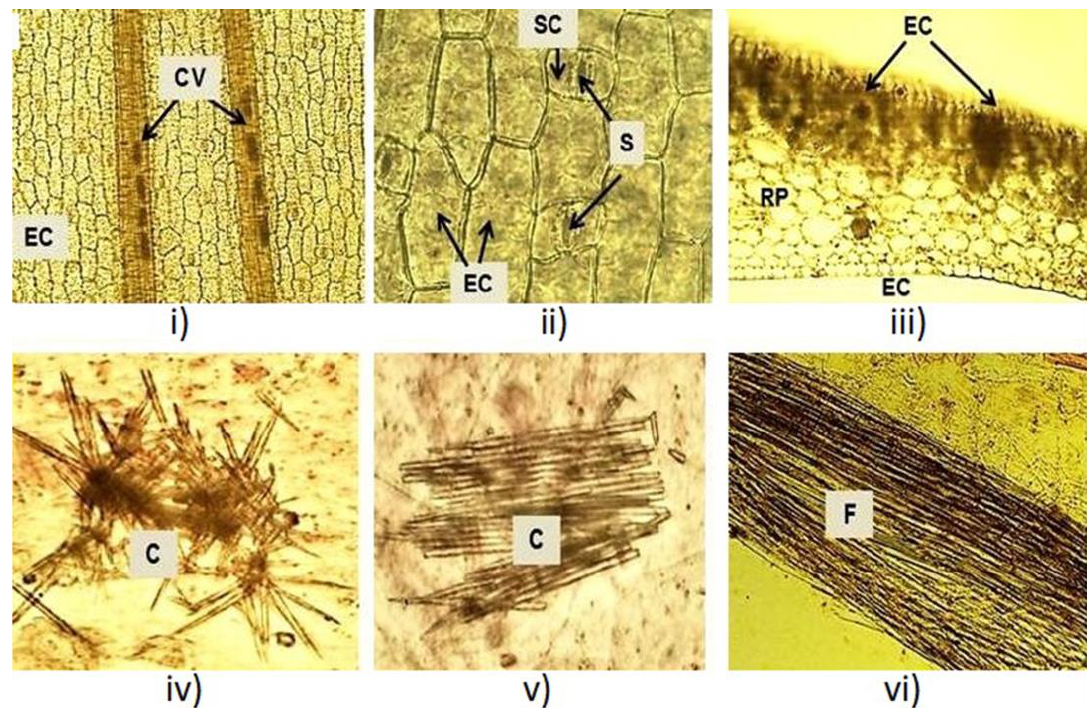
Figure 2. Microscopic characteristics of the X. caeruleum leaves. CV: Conductive vessels; EC: Epidermal cells; S: Stomata; RP: Reserve parenchyma; C: Crystals; F: Fibers.